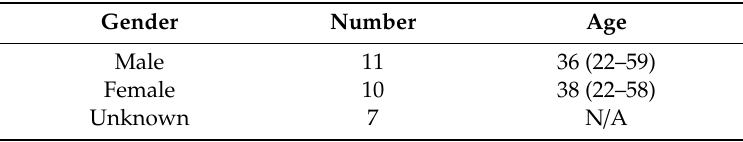
Table 1. Demographics of the healthy donors recruited for the